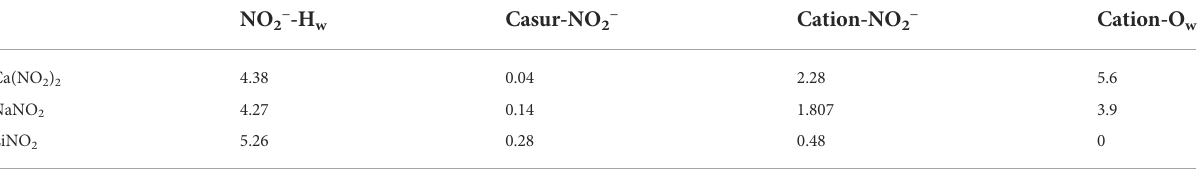
TABLE 1 The average coordination number